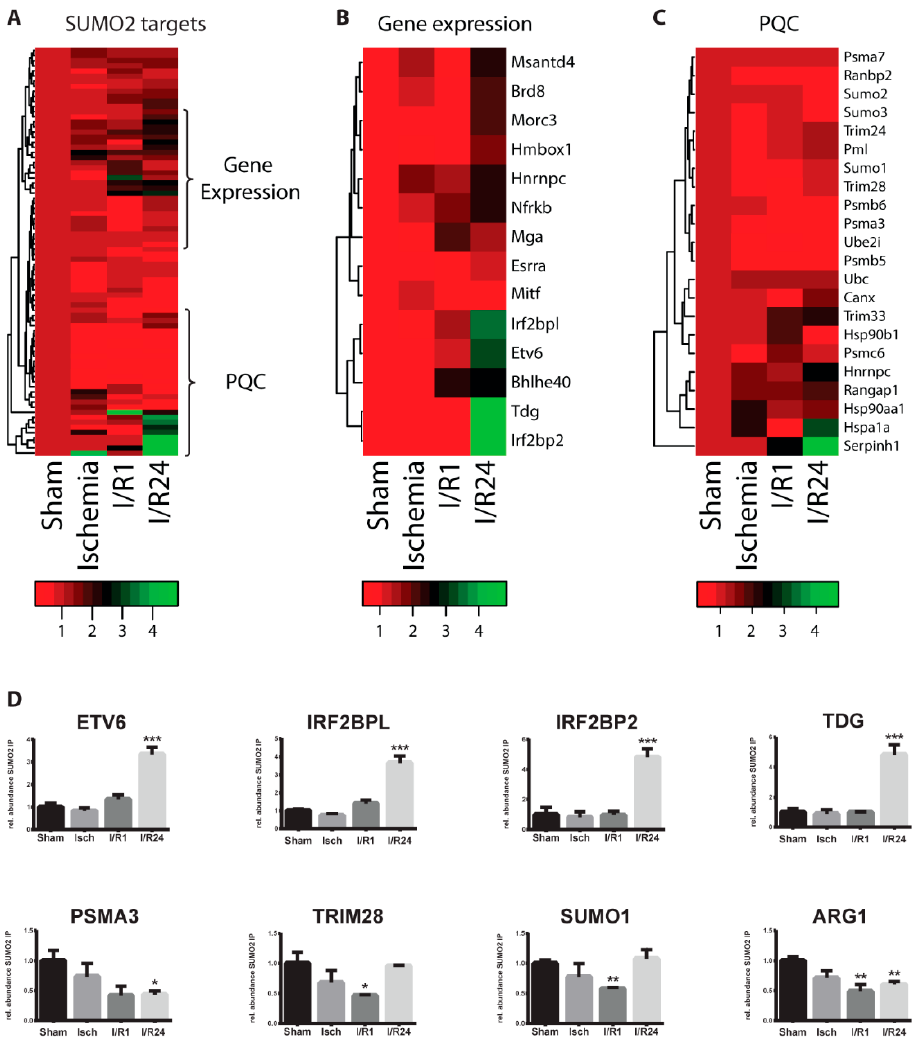
Figure 5. Cardiac I/R injury leads to dynamic changes in SUMO2 proteome. ( A ) Alteration of Figure 5. Cardiac I / R injury leads to dynamic changes in SUMO2 proteome. ( A ) Alteration of SUMO2 / 3 SUMO2/3 target proteins upon cardiac I/R injury in the mouse heart. The heat map displays relative target proteins upon cardiac I / R injury in the mouse heart. The heat map displays relative changes in changes in SUMO2/3 targets during I/R when compared to sham control. SUMO2/3 targets were SUMO2 / 3 targets during I / R when compared to sham control. SUMO2 / 3 targets were defined after defined after imputation as follows, difference SUMO2/3 IP versus IgG IP log 2 ratio > 0.58 (difference imputation as follows, di ff erence SUMO2 / 3 IP versus IgG IP log 2 ratio > 0.58 (di ff erence is higher than is higher than 1.5×) and ‐ log 10 p value > 1.3 ( p < 0.05). ( B ) Heatmap of a sub ‐ group of SUMO2/3 target 1.5 × ) and -log 10 p value > 1.3 ( p < 0.05). ( B ) Heatmap of a sub-group of SUMO2 / 3 target proteins proteins playing a role in the regulation of gene expression in the mouse heart upon I/R injury. ( C ) playing a role in the regulation of gene expression in the mouse heart upon I / R injury. ( C ) Heatmap of a Heatmap of a sub ‐ group of SUMO2/3 target proteins belonging to the protein quality control sub-group of SUMO2 / 3 target proteins belonging to the protein quality control machinery (UPS, SUMO machinery (UPS, SUMO system, chaperones) in the mouse heart upon I/R injury. ( D ) Bar diagrams of system, chaperones) in the mouse heart upon I / R injury. ( D ) Bar diagrams of significantly changed significantly changed SUMO2/3 targets, when experimental conditions (Isch, I/R1, I/R24) are SUMO2 / 3 targets, when experimental conditions (Isch, I / R1, I / R24) are compared to Sham. Data are compared to Sham. Data are expressed in mean ± SEM, asterisks show significant differences expressed in mean ± SEM, asterisks show significant di ff erences compared to Sham ( n = 3, * p < 0.05, compared to Sham ( n = 3, * p < 0.05, ** p < 0.01, *** p < 0.001). ** p < 0.01, *** p <